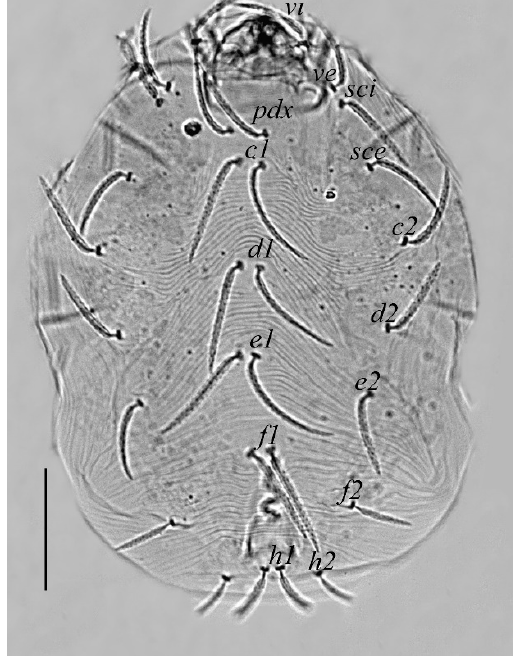
Figure 3. Neophyllobius combreticola . Female. Dorsum. Scale bar: 100 μ m.